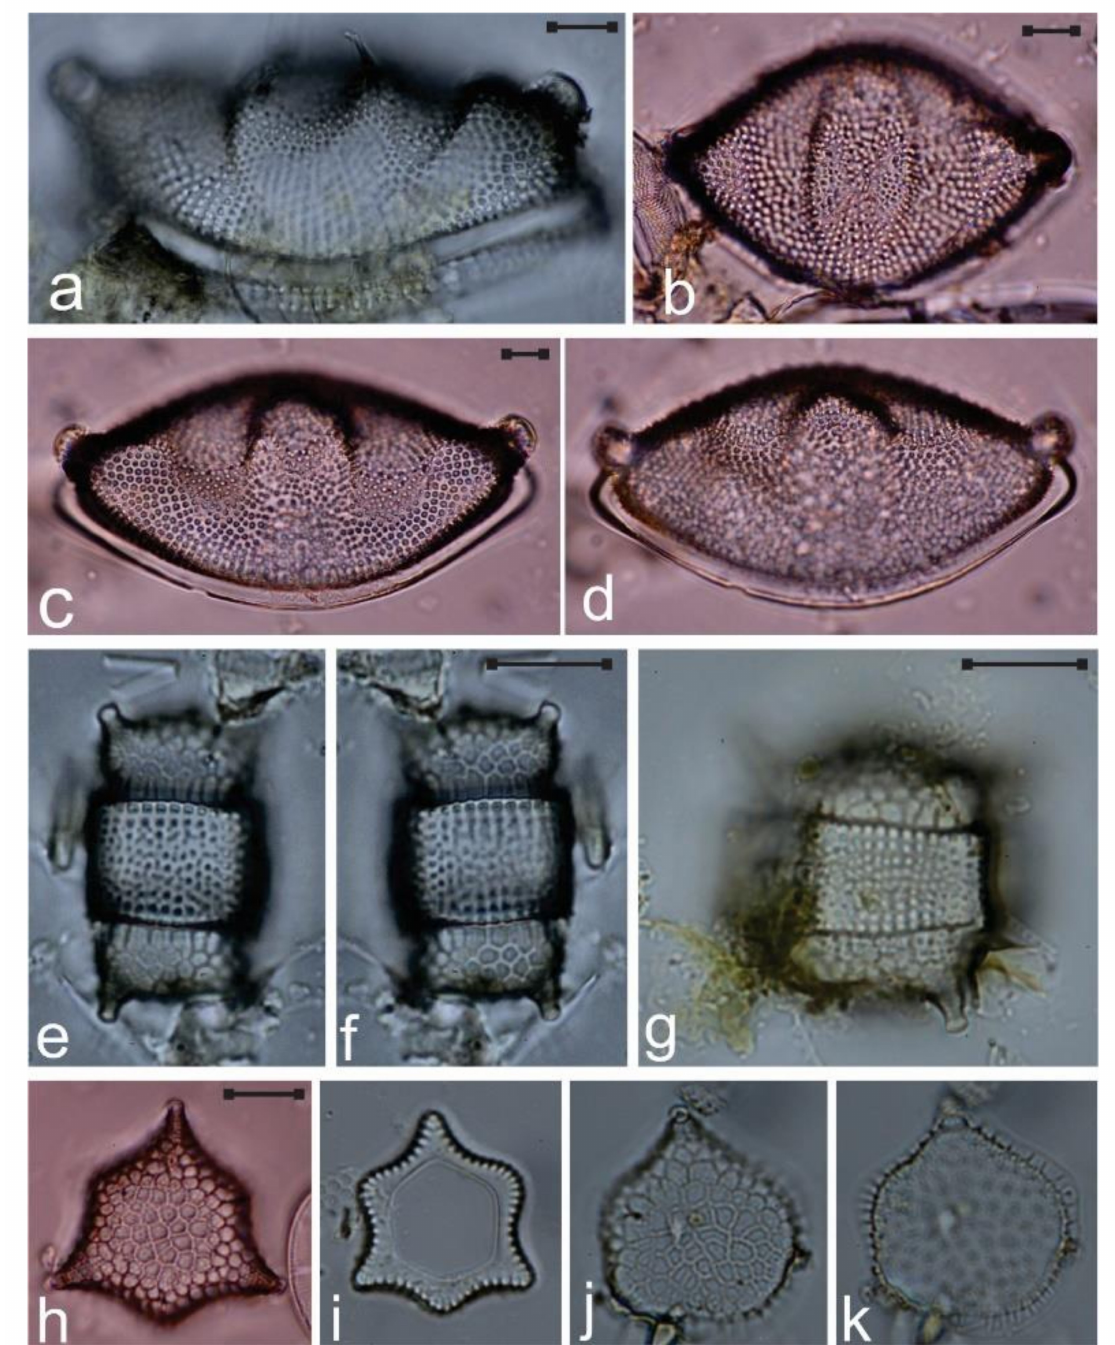
Figure 13. ( a – d ) Odontella obtusa ; ( e – k ) Pseudictyota dubia , images e – g frustule in girdle view showing the cingulum, images h – k valve view at four focal planes. Scale bar = 10 µ